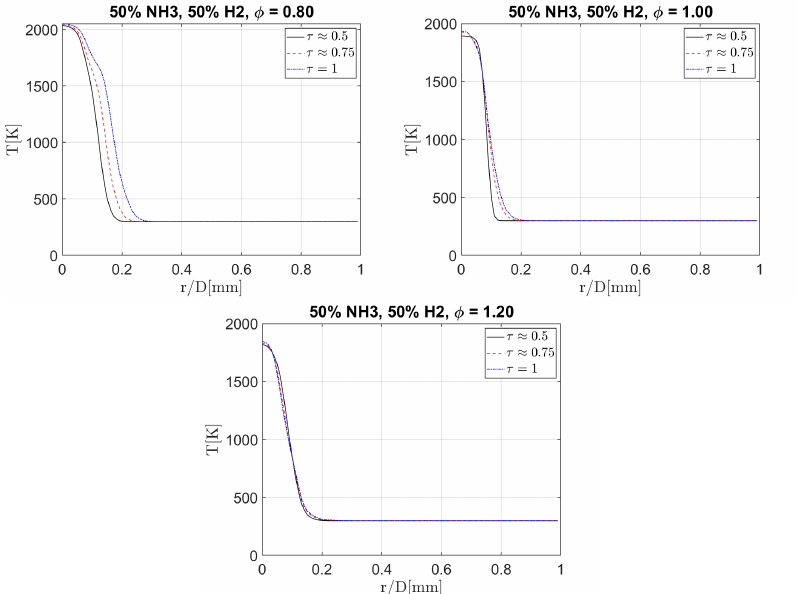
Figure 14. Conditional average of temperature averaged over r for 50%